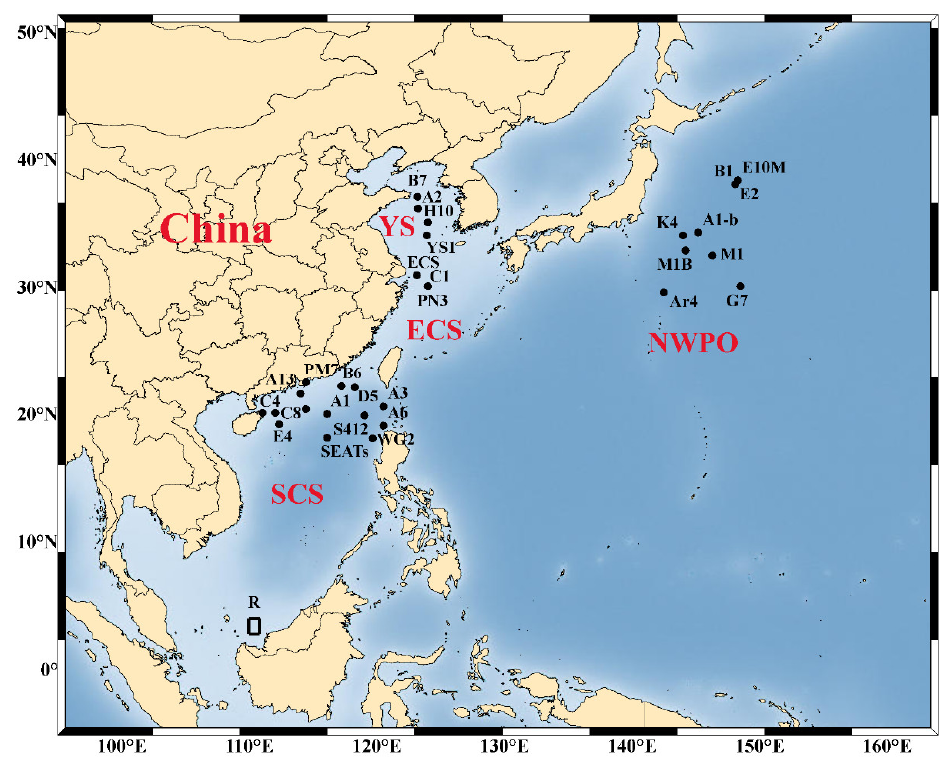
Figure 2. Sampling sites for aerosol amendment bioassays conducted in northwest Pacific Ocean (NWPO) and its marginal seas. ECS, East China Sea; SCS, South China Sea; YS, Yellow Sea.